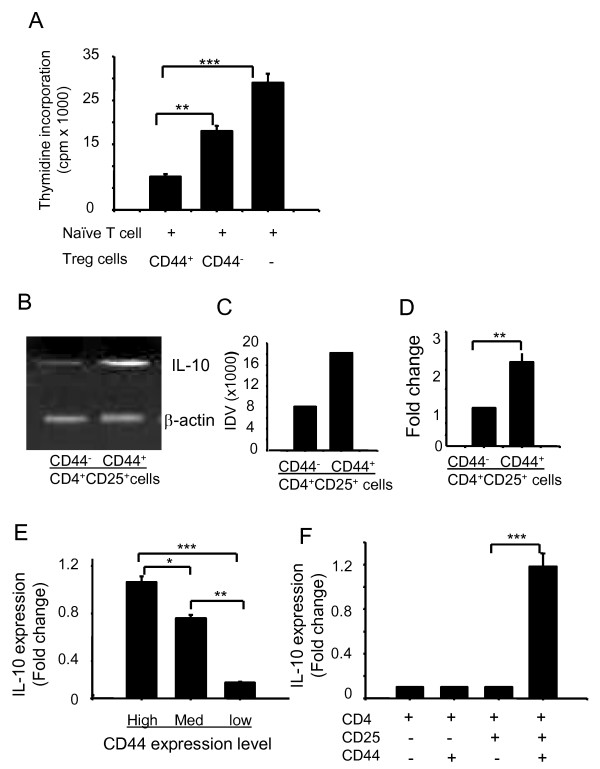
Regulatory function of CD4+ CD25+ CD44+ and CD4+ CD25+ CD44- splenocytes. (A) CD4+CD25+CD44+ and CD4+CD25+CD44-cells were sorted from the splenocytes of C57BL/6 mice, and these cells (1 × 105/well) were co-cultured with naïve T cells (2 × 105/well) in the presence of Con A for 72 h. T cell proliferation was measured by incorporation of [3H]-thymidine. Data are presented as counts per min, and shown are the mean ± S.D. from three independent experiments. (B) Total RNA was extracted from purified CD4+CD25+CD44+ and CD4+CD25+CD44- cells for RT-PCR analysis of IL-10 expression. (C) The integrated density values (IDV) for the IL-10 transcripts were quantitated and normalized to those of β-actin. Shown are representative results from one of three independent experiments. (D) The data were pooled from three independent experiments and shown in the plot. (E) The levels of IL-10 mRNA among different subsets of CD44+ expressing cells. CD4+CD25+CD44high, CD4+CD25+CD44med and CD4+CD25+CD44low cells were sorted from the spleens of naïve mice. (F) CD4+CD8-CD25+CD44+, CD4+CD8-CD25+CD44-, CD4+CD8-CD25-CD44+, and CD4+CD8-CD25+CD44- cells were sorted from the thymus of naive mice. Total RNA was isolated for measuring IL-10 mRNA by real-time RT-PCR. Data are presented as fold-induction relative to the levels of β-actin. Shown are representative results one of three independent experiments.(* p < 0.05, ** p < 0.01, *** p < 0.001).